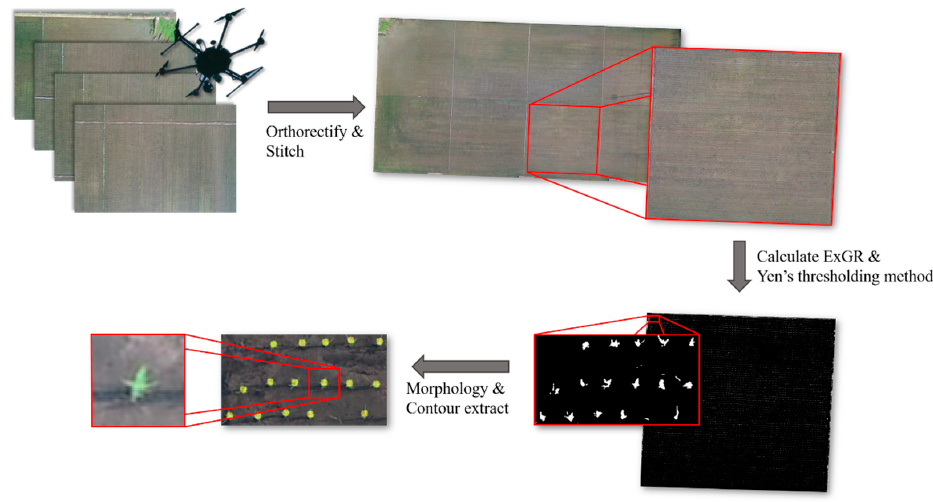
Figure 4. The workflow of semi-auto annotation.